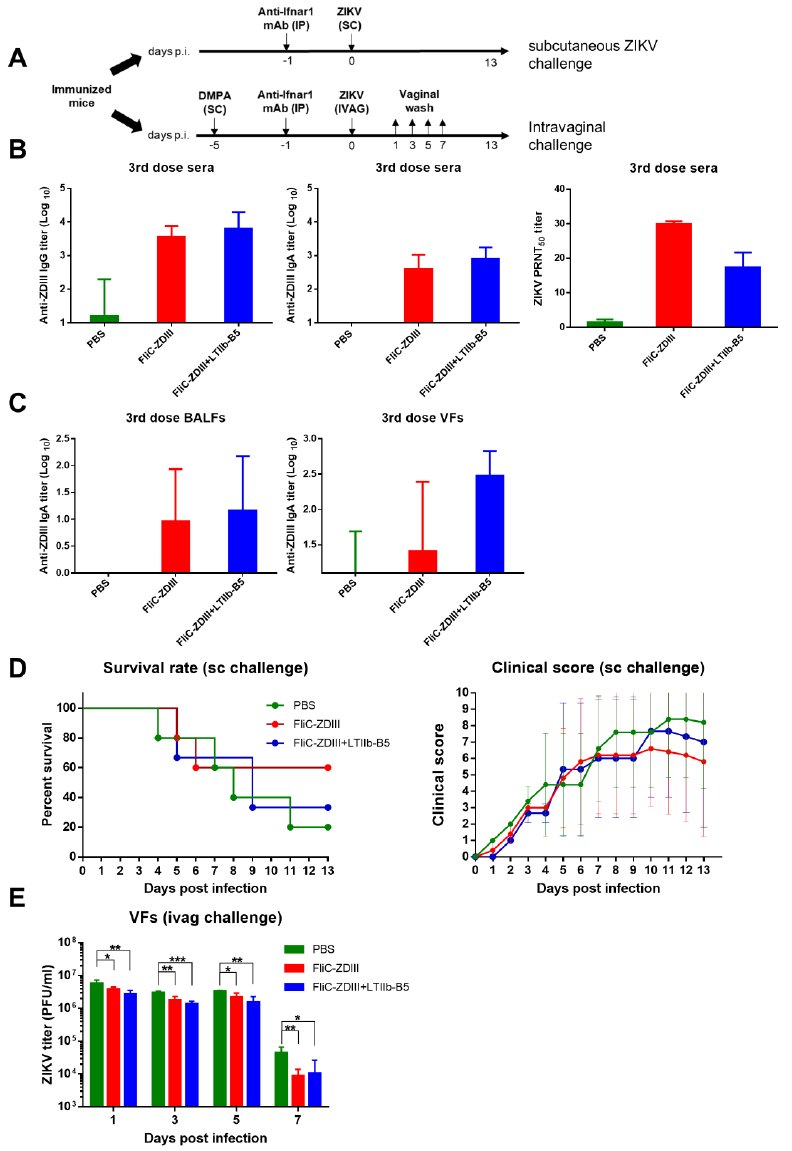
Figure 4. Systemic and vaginal tract protection against ZIKV challenges in FliC ‐ ZDIII ‐ immun ‐ ized mice. ( A ) Groups of BALB/c mice (n = 5 per group) were intranasally immunized with PBS, 40 μ g FliC ‐ ZDIII, and 40 μ g FliC ‐ ZDIII + 3 μ g LTIIb ‐ B5 adjuvant for three doses in a 3 ‐ week